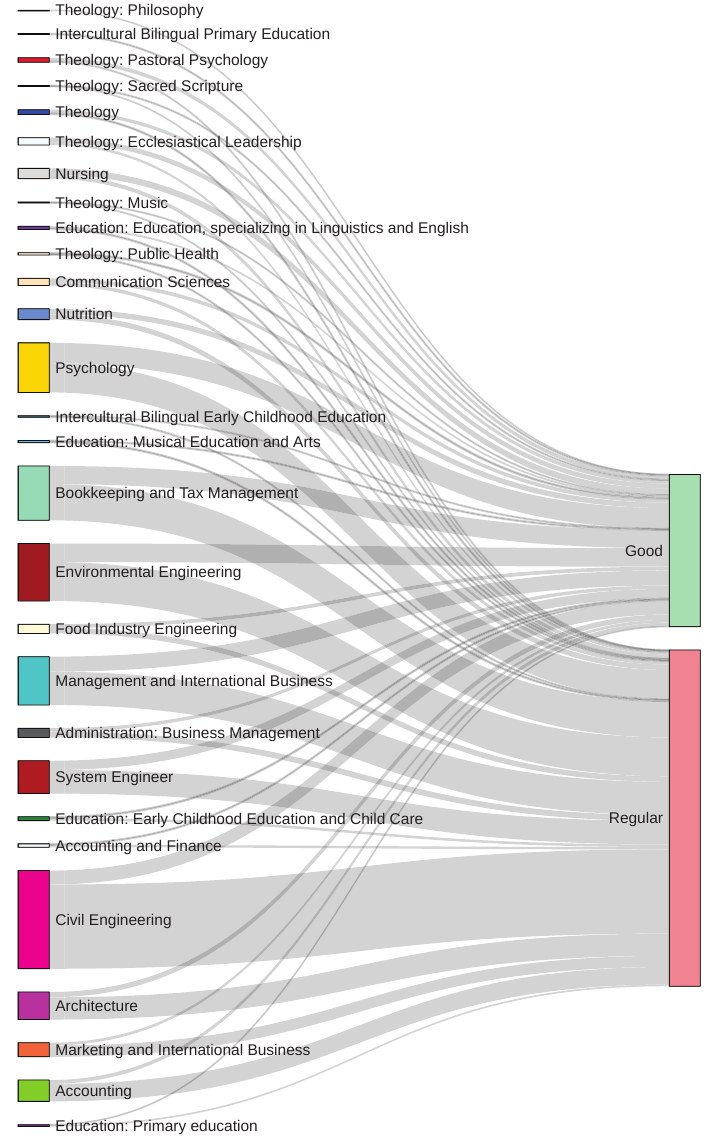
Figure 5. Student’s Performance Classification distributed over